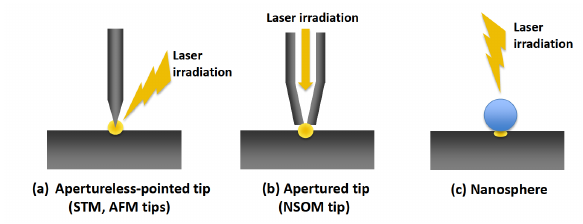
Figure 5: Schematic diagrams of three schemes for nanoablation using the optical near-field. (a) Apertureless-pointed tips used for scanning tunneling microscopy (STM) and atomic force microscopy (AFM), (b) apertured tips used for near-field scanning optical mi- croscopy (NSOM), and (c) dielectric and metal nanospheres.